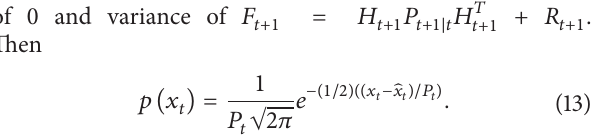
of 0 and variance of 𝐹